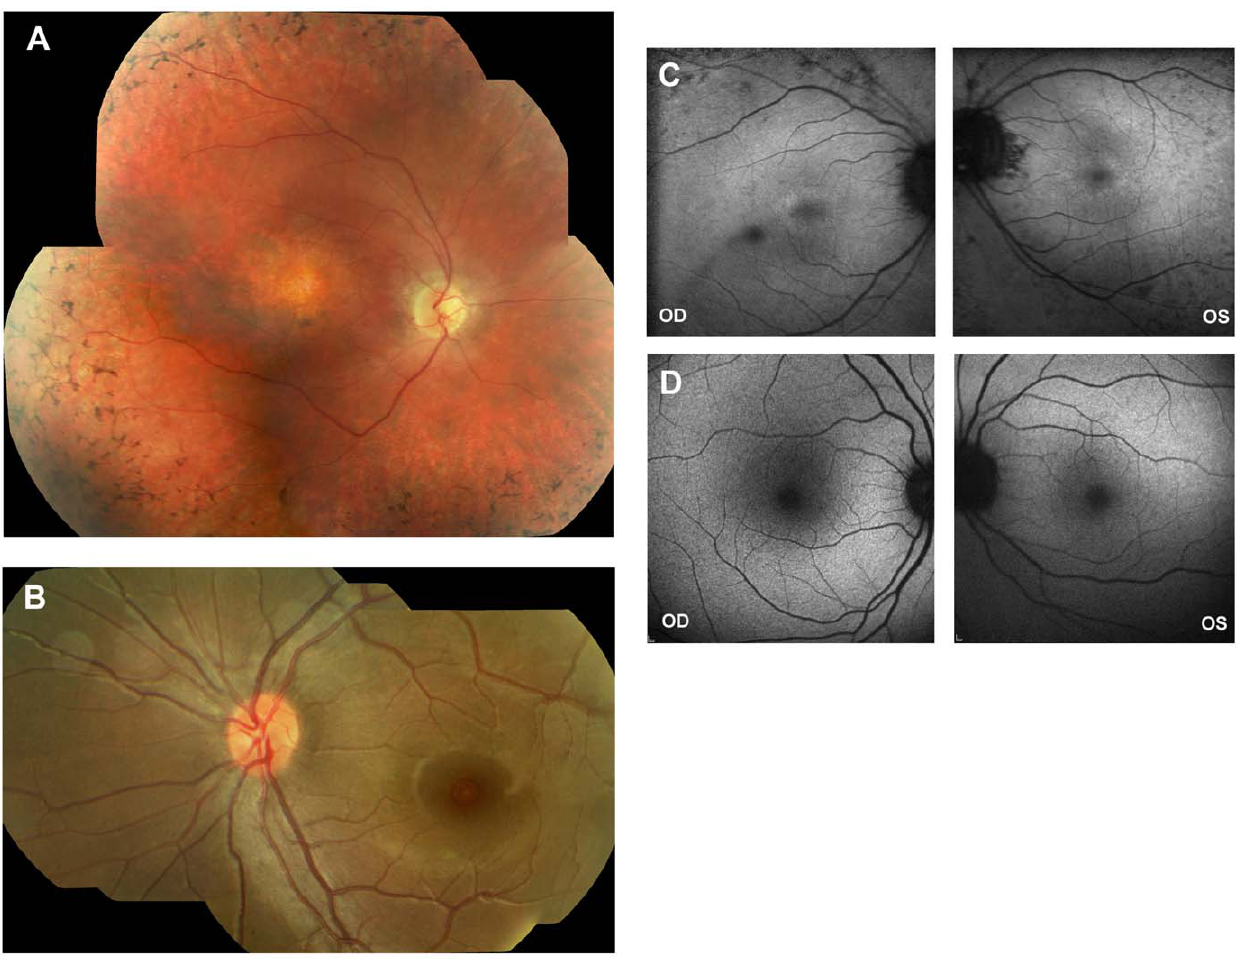
Figure 1. Colour fundus photographs and autofluorescence imaging of patients with AIPL1-associated retinal dystrophy. A. Colour fundus photograph of the right eye of case 2 at age 24 years, showing typical findings in an older subject with AIPL1 -related retinal dystrophy. Characteristic features include bone spicule retinal pigmentation in the mid-periphery, macular atrophy and optic nerve pallor. B. Colour fundus photograph of the left eye of case 3 at age 2 years. The fundus appears unremarkable with minimal changes at the fovea. C. Autofluorescence (AF) imaging of case 1 at age 19 years showing evidence of a mild generalised reduction in AF at the posterior pole, with relatively preserved macular AF. D. Autofluorescence imaging in case 6 at age 17 showing good preservation of macular AF and some loss of foveal AF secondary to atrophy.